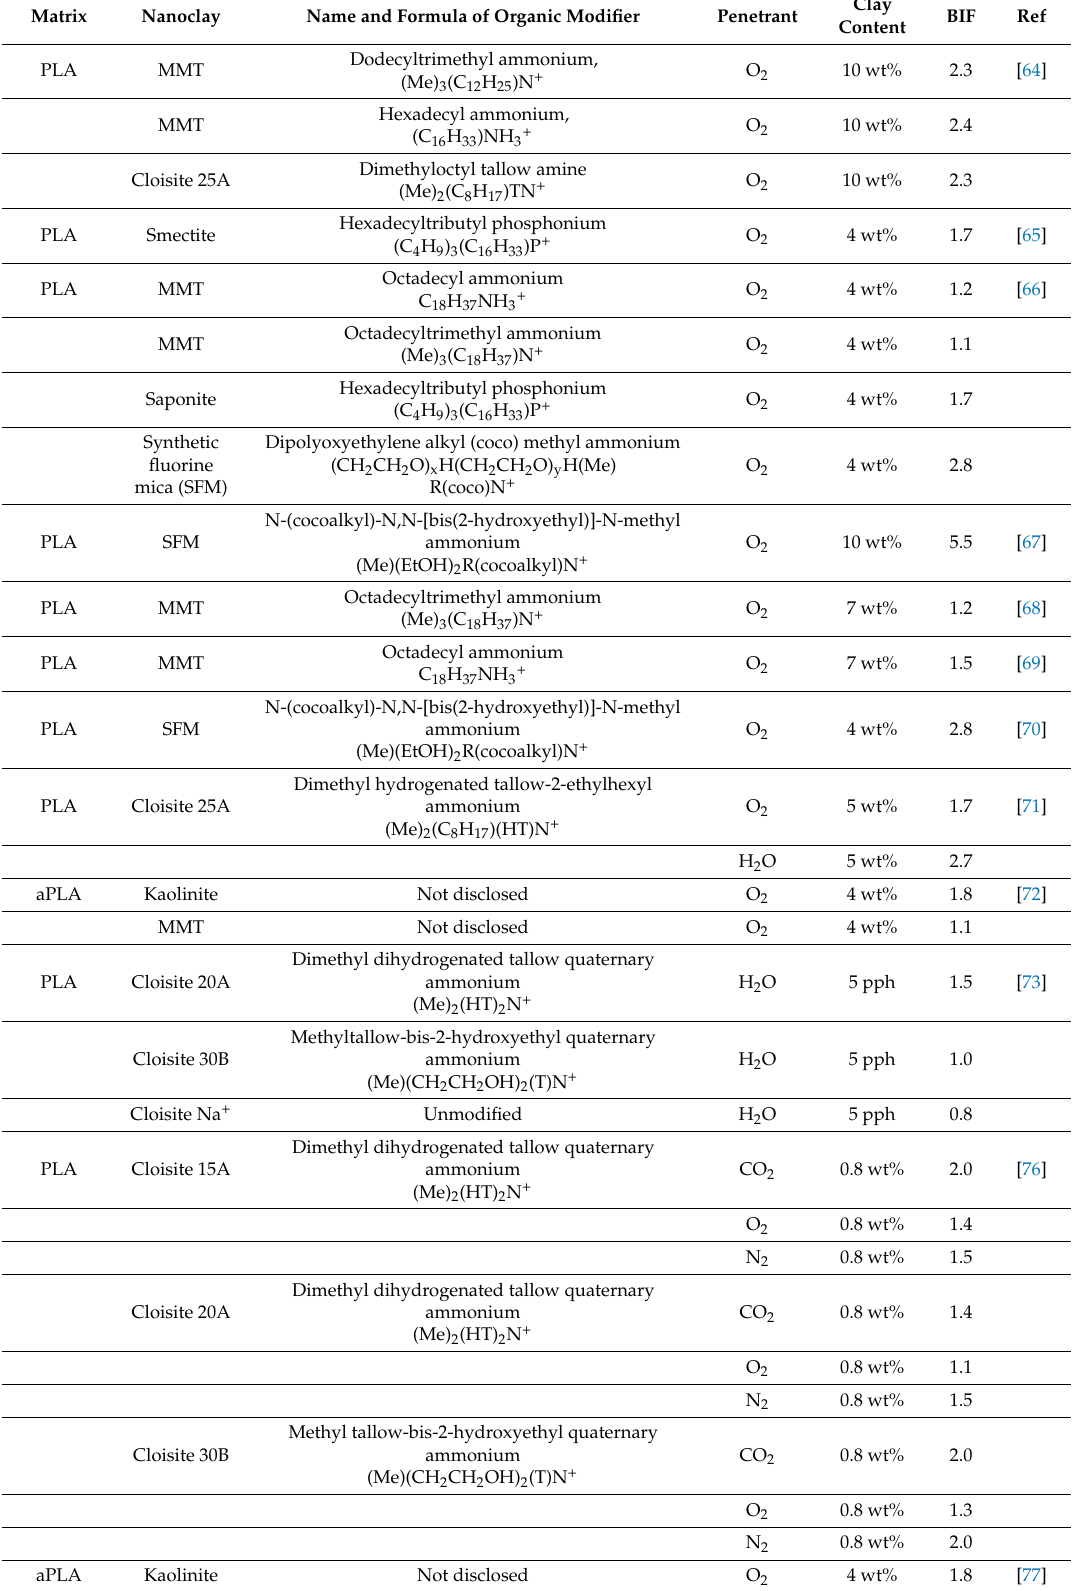
Table 1. Barrier improvement factors (BIFs) for PLA / clay